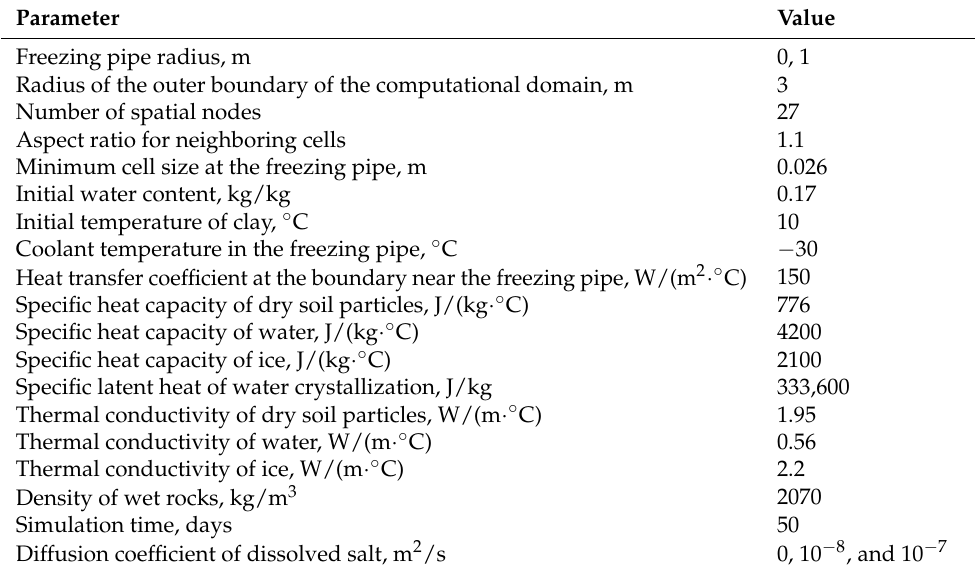
Table 4. Parameters for numerical